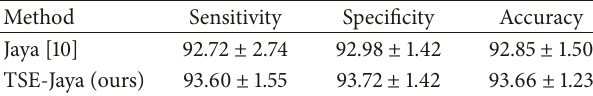
Table 9: Plain Jaya algorithm versus the proposed TSE-Jaya.